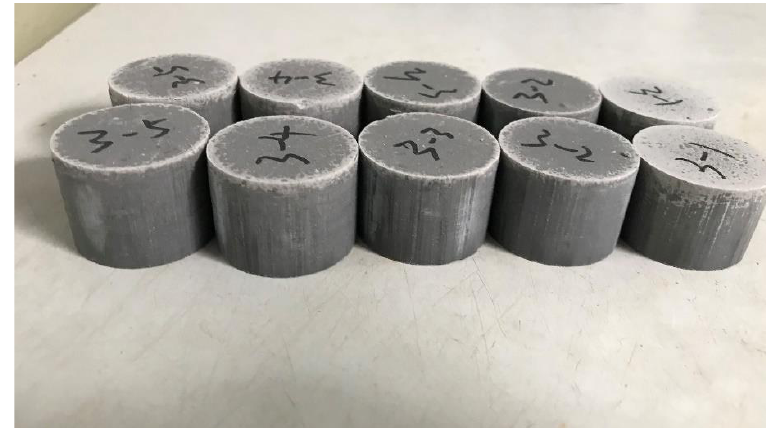
Figure 2. Sample of unburned brick.